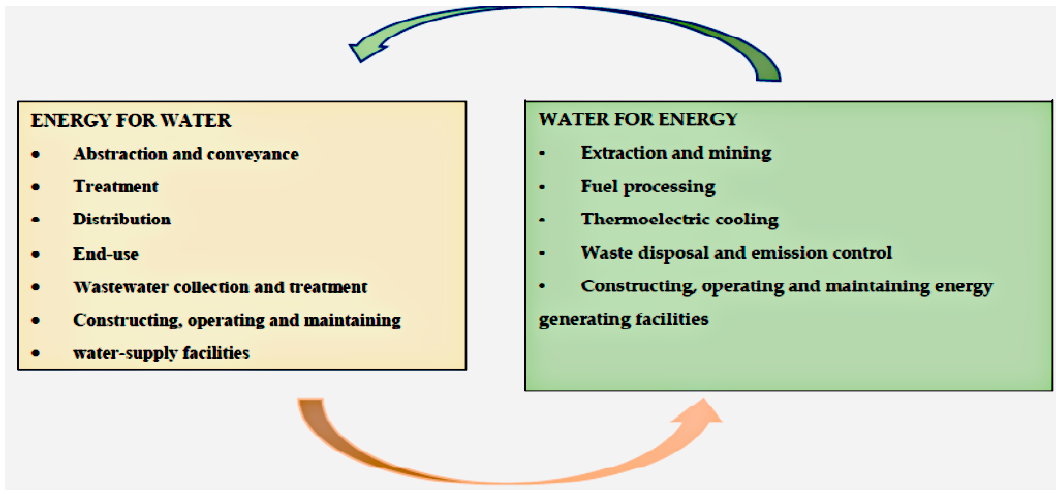
Figure 4. Illustration of the water-energy nexus adapted from [28].